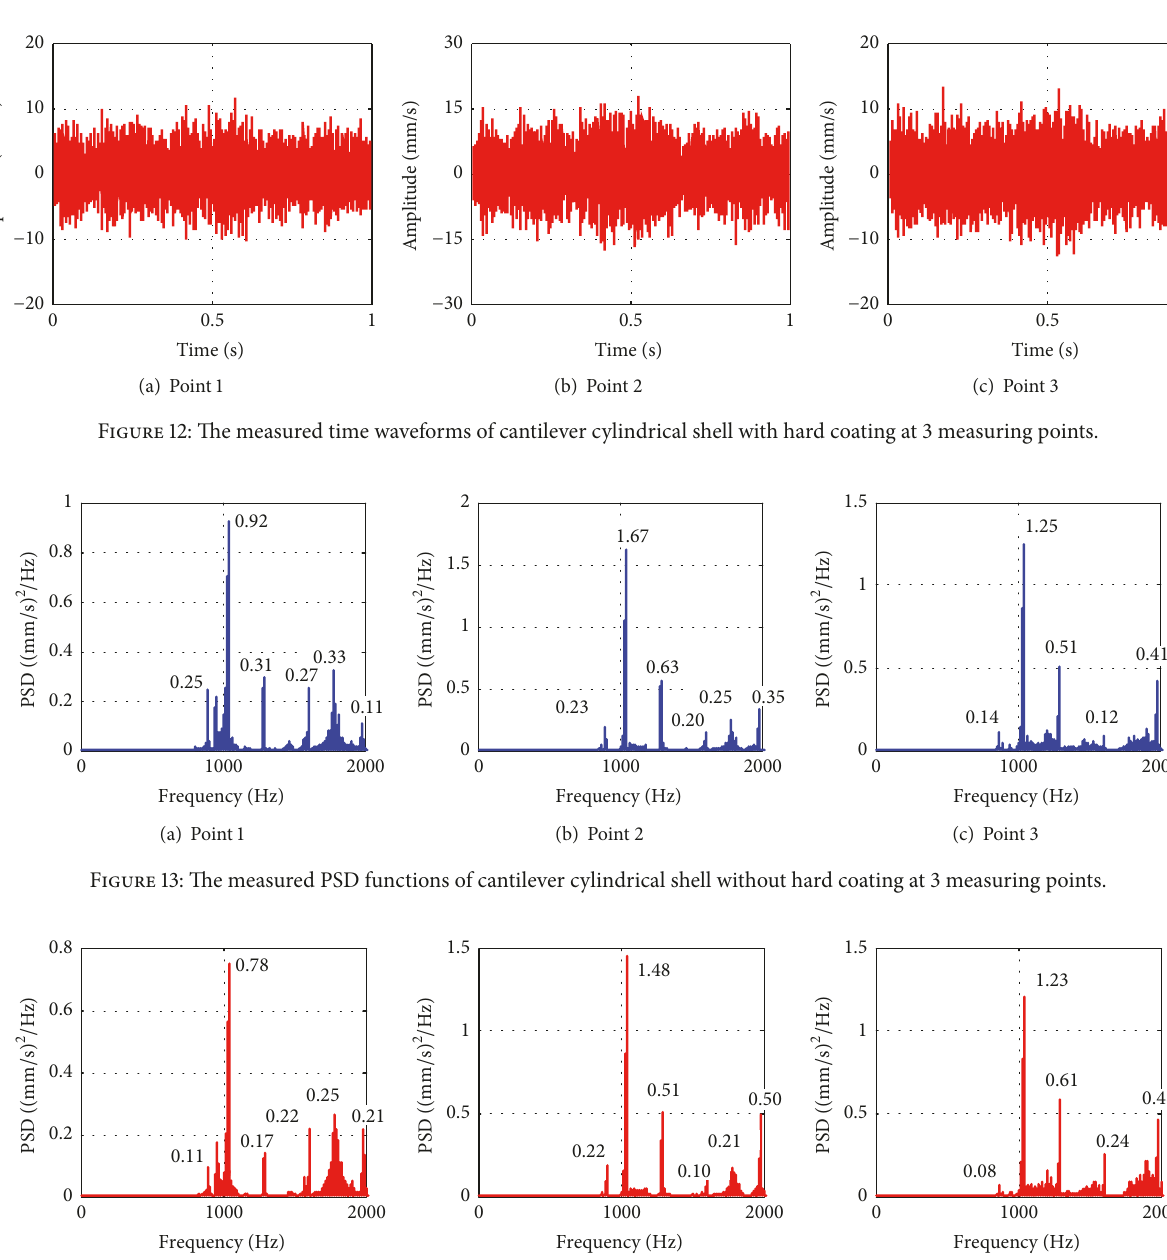
or no coating states are close to each other, which show the resulting frequencies are less affected by hard